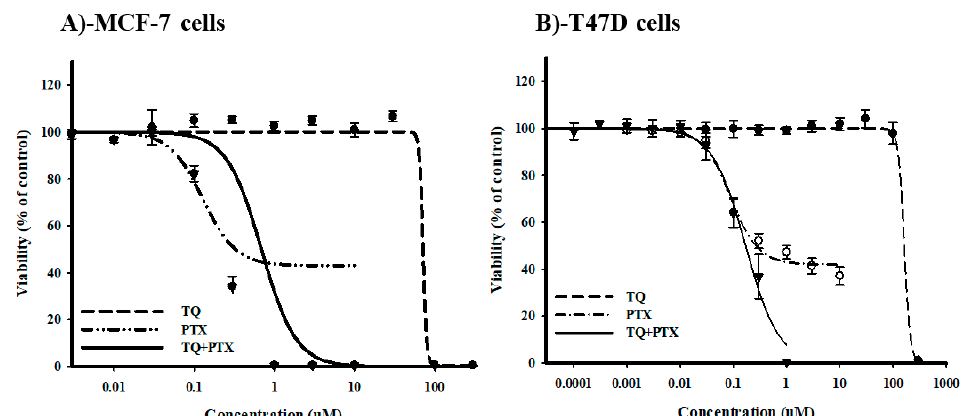
Figure 1. The effect of thymoquinone (TQ) on the dose-response curve of paclitaxel (PTX) in MCF-7 ( A ) and T47D ( B ) breast cancer cell lines. Cells were exposed to the serial dilution of PTX, TQ, or their combination for 72 h. Cell viability was determined using a sulfarodamine-B (SRB) assay, and data are expressed as mean ± SD ( n = 3). Table 1. Combination analysis of cell cytotoxicity for TQ, PTX, and their combination against MCF-7 and T47D breast cancer cell lines.